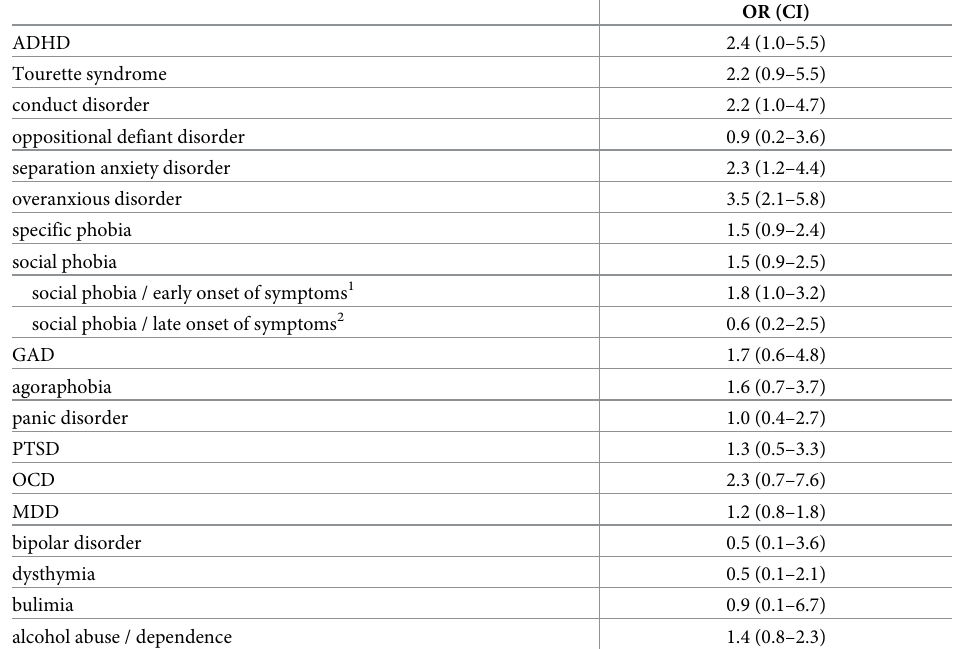
Table 6. PsyCoLaus: Associations between stuttering and neurodevelopmental / common mental disorders. Odds ratios and confidence intervals (95%), adjusted for sex.